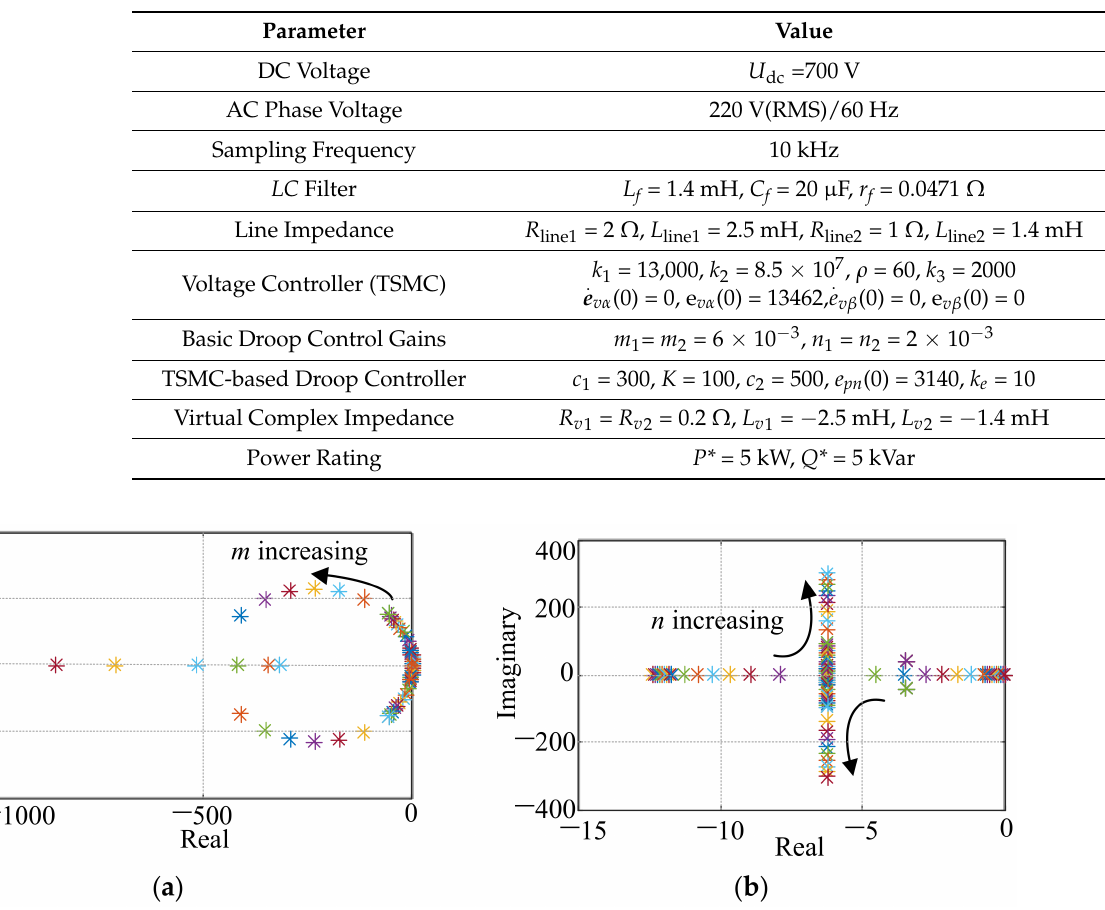
Table 2. Detail system parameters.